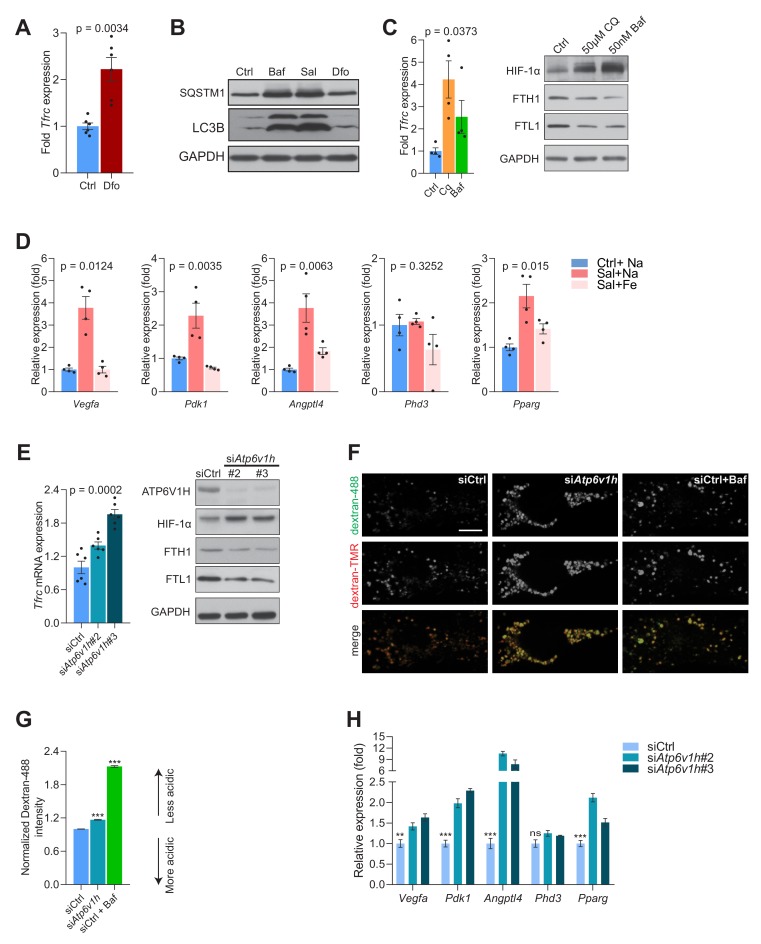
HIF-1a mediated response is triggered by lack of lysosomal iron efflux.(A) Increased Tfrc mRNA levels in fibroblasts treated with lysosomal iron chelator, Dfo (300 µM) for 24 hr. Bar graphs represent mean ± SEM for six independent experimental measures (shown as black dots). p-value is unpaired two-tailed t-test with Welch’s correction. (B) Immunoblots of SQSTM1 and LC3B in 500 nM Baf- and 500 nM Sal-treated fibroblasts (n = 6). 300 µM Dfo is used as positive control for the independence of impaired lysosomal iron efflux on defective autophagy. GAPDH is used as loading control. (C) Increased Tfrc mRNA levels in fibroblasts treated with either vehicle control, 50 µM Chloroquine (CQ) or 50 nM Baf for 24 hr (left). Bar graphs represent mean ± SEM for four independent experimental measures (shown as black dots). p value is Welch’s one-way ANOVA with all experimental groups compared to vehicle control treated cells. Multiple test corrections were by the Dunnett’s method. Immunoblots of HIF-1α, FTH1 and FTL1 with GAPDH as loading control in whole cell lysates prepared from fibroblasts treated for 24 hr with either vehicle control, 50 µM Chloroquine (CQ) or 50 nM Baf (right). Blots are representative of n = 4 biological replicates. (D) Expression level of HIF-1a target genes in 500 nM Sal- and 500 nM Sal-treated fibroblasts with 150 µM iron citrate supplementation. p values are estimated as Welch’s one-way ANOVA with all experimental groups compared to Sal-treated cells. Multiple test corrections were by the Dunnett’s method. (E) Tfrc mRNA levels in fibroblasts with siRNA mediated silencing of Atp6v1h subunit of the vATPase (left). Relative Tfrc expression is shown as bars representing mean ± SEM, n = 6 biological replicates (black dots). p value is determined by the Welch’s one-way ANOVA followed by Dunnett’s correction for multiple comparisons of all groups to the siCtrl group. Efficient knockdown is shown as immunoblot of ATP6V1H (right). Immunoblots of HIF-1α, FTH1, FTL1 with GAPDH as loading control are also shown for n = 3 biological samples in fibroblasts with Atp6v1h knockdown. (F–G) Silencing of Atp6v1h in fibroblasts results in impaired lysosomal acidification. Representative spinning-disk microscopy images for siCtrl and siAtp6v1h fibroblasts were co-stained with Dextran-Oregon Green 488 and Dextran-TMRM with Baf treatment in siCtrl cells used as a positive control for impaired acidification. Scale bar 2 µm. (G) Quantification of the intensity of Dextran-Oregon Green in Dextran-TMRM positive punta shows increased Dextran-Oregon Green intensity in Atp6v1h knockdown fibroblasts and in Baf-treated siCtrl fibroblasts. Bar graphs depict mean ± SEM, n = 3 independent experiments, with 20 cells per condition from each experiment. ***p<0.001, determined by the unpaired two-tailed t-test with Welch’s correction (H) Expression level of HIF-1a target genes following Atp6v1h knockdown in fibroblasts. p values are estimated as Welch’s one-way ANOVA with all experimental groups compared to siCtrl cells. Multiple test corrections were by the Dunnett’s method.